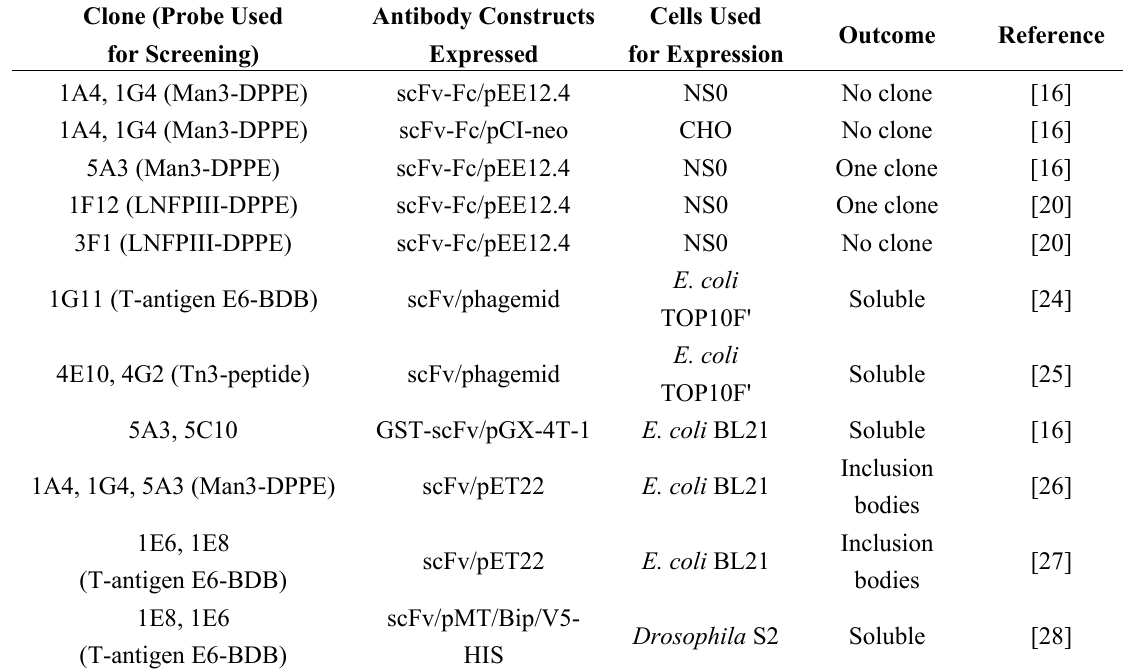
Table 2. Summary of the expression and purification of various scFv proteins in eukaryotic and prokaryotic